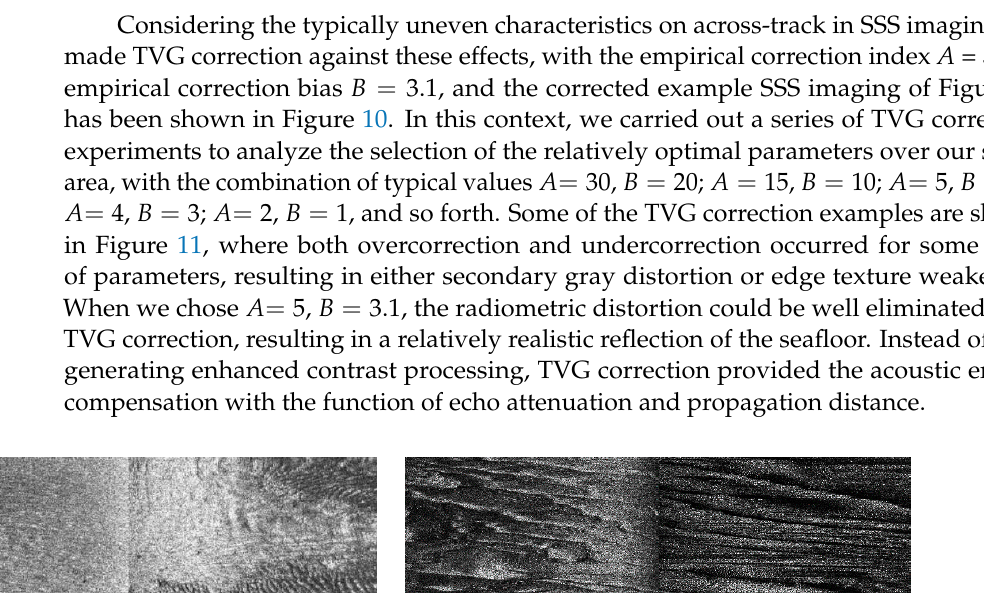
Figure 9. Example echo intensity sub-sequence extraction from raw SSS imaging.